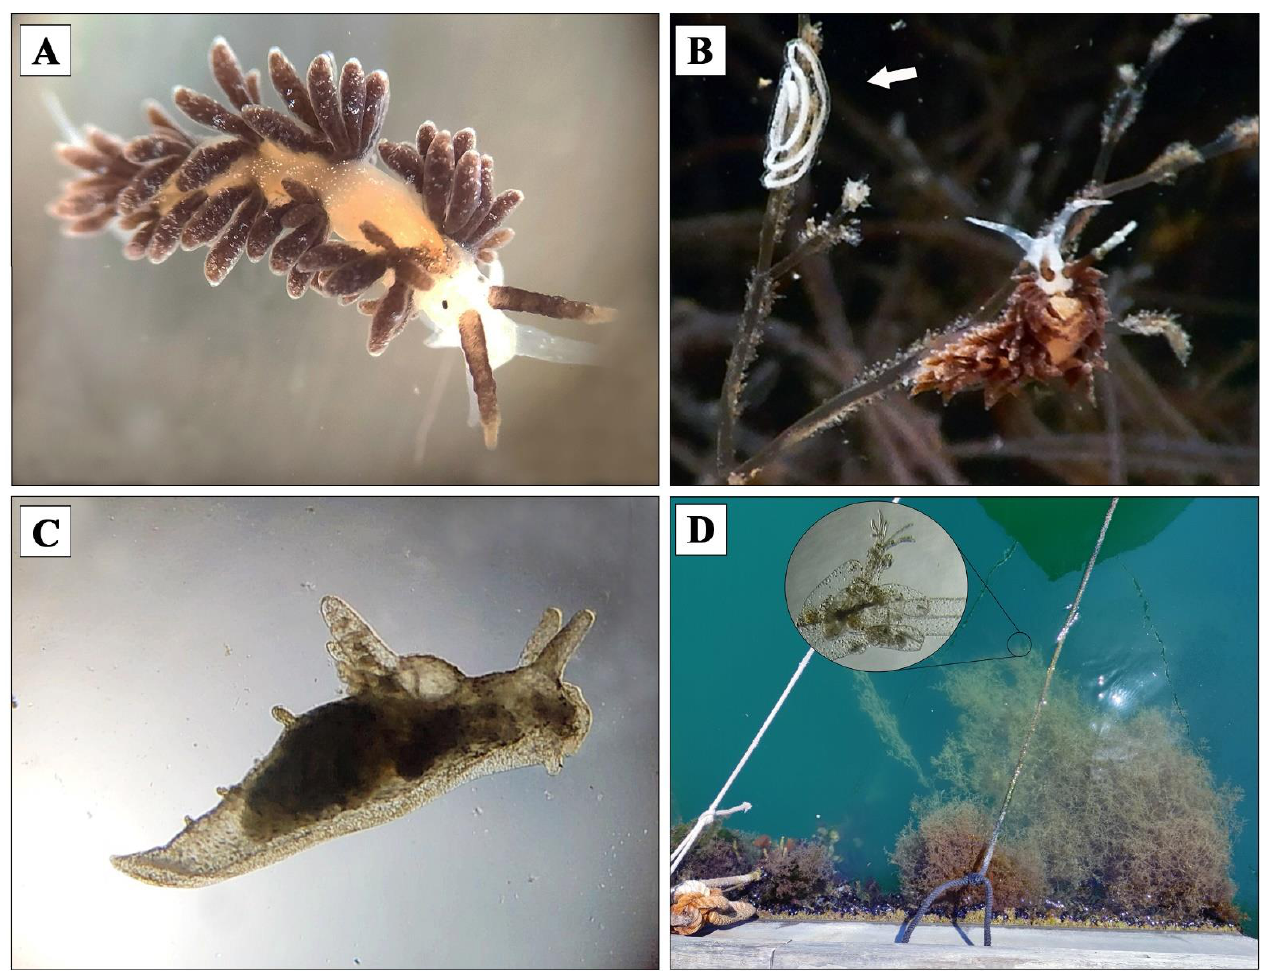
Figure 2. ( A , B ) Pictures of F. ghanensis obtained in laboratory ( A ) and in situ ( B ). Highlighted by the white arrow is an egg ribbon, possibly laid by F. ghanensis . ( C ) Polycerella emertoni photographed in laboratory under a stereomicroscope. ( D ) Colonies of A. verticillata living in the marina of Fezzano. Table 2. Species names, collection localities, vouchers, and COI accession numbers of the specimens included in the molecular analyses. The ‘*’ symbol indicates the outgroups. In bold are the Ligurian specimens that were molecularly from F. ghanensis individuals and two COI, 16S, and H3 (637 bp, 411 bp, and 324 bp, re-